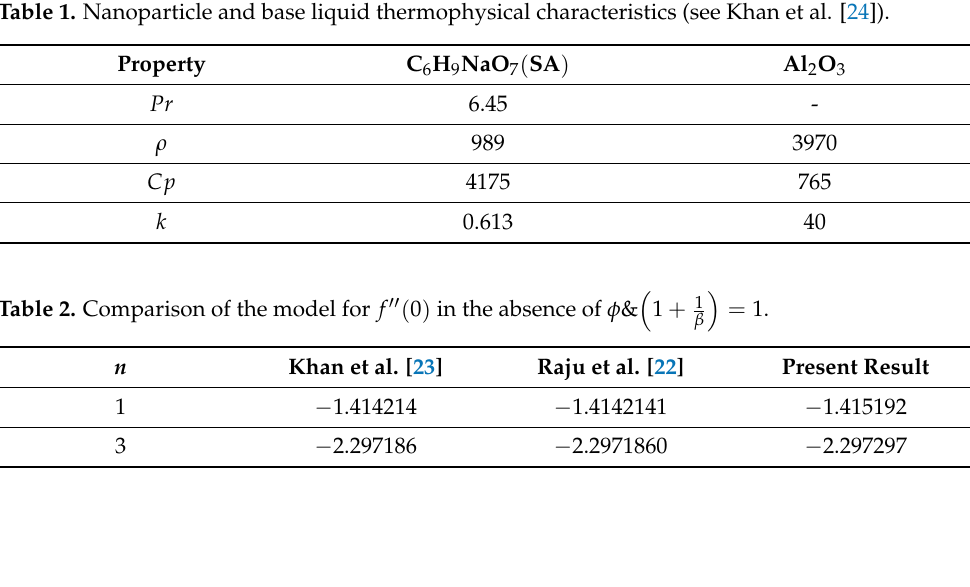
Table 2. Comparison of the model for f (cid:48)(cid:48) ( 0 ) in the absence of φ &